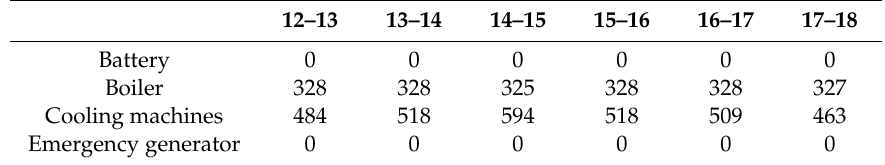
Table 6. Baselines for iteration